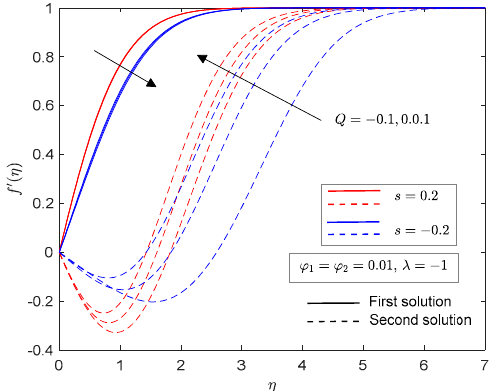
Figure 8. Influence of heat source/sink on f (cid:48) ( η ) Figure 8 . Influence of heat source/sink on